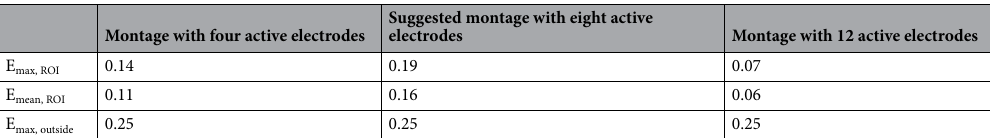
Table 4. Maximum and mean electric field in the retina for three different conditions: (1) a montage with four active electrodes, (2) the suggested montage with eight active electrodes, and (3) a montage with 12 active electrodes. E max, ROI , E mean, ROI , E max, outside represent the maximum electric field in ROI, mean electric field in ROI, and maximum electric field outside ROI, respectively. (Unit: V/m).